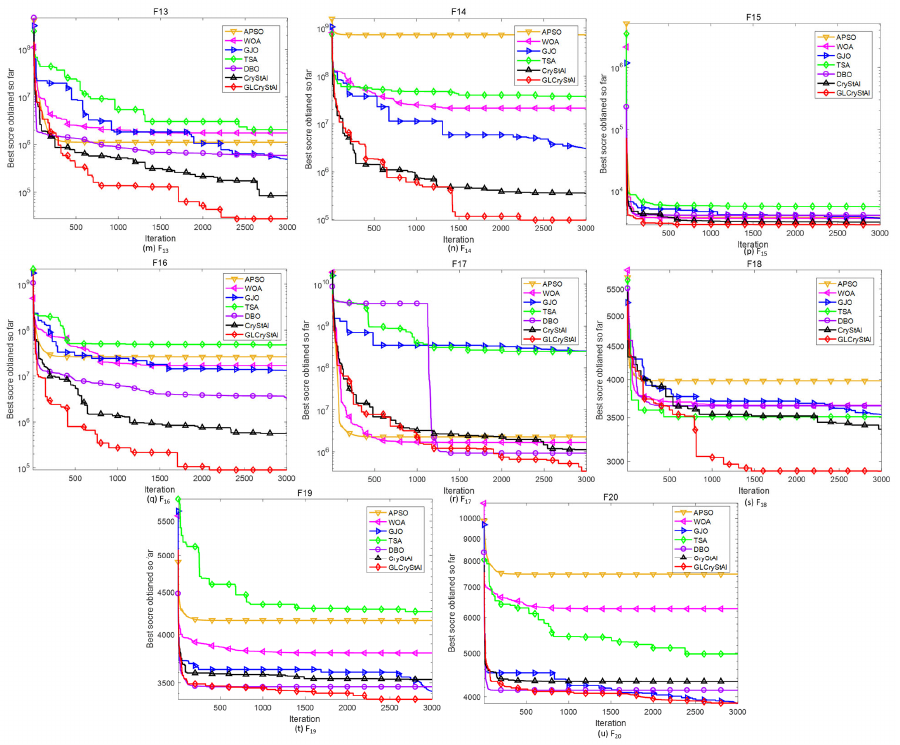
Figure 2. Convergence curve of each algorithm.